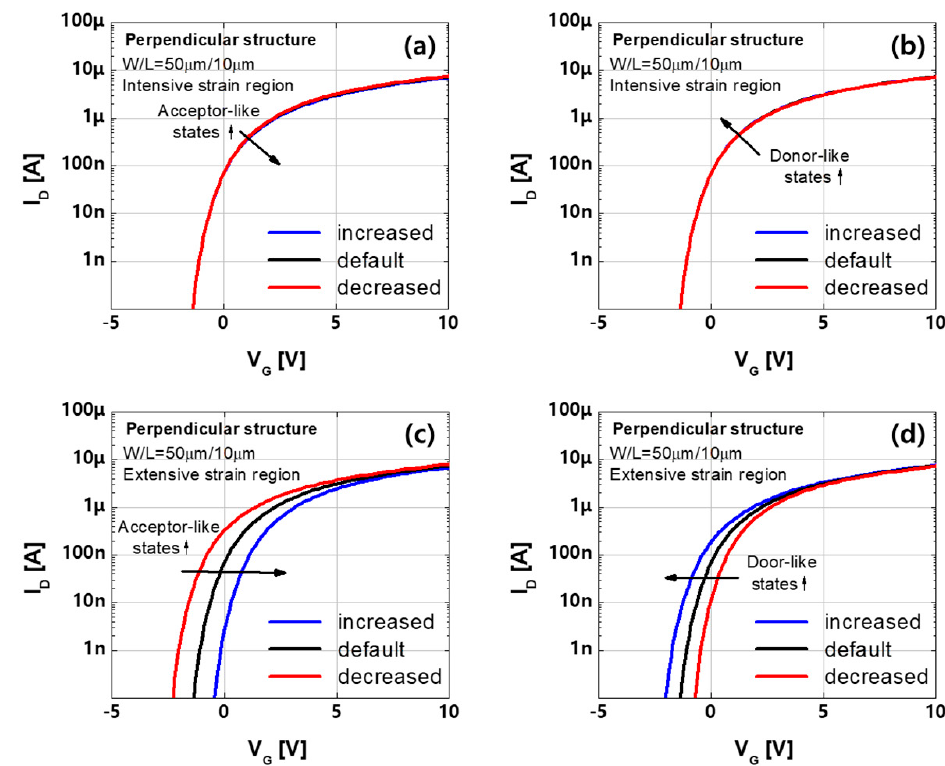
Figure 7. Effects of trap state variation in the ( a , b ) intensive and ( c , d ) extensive regions of the perpendicular multi–region structure.